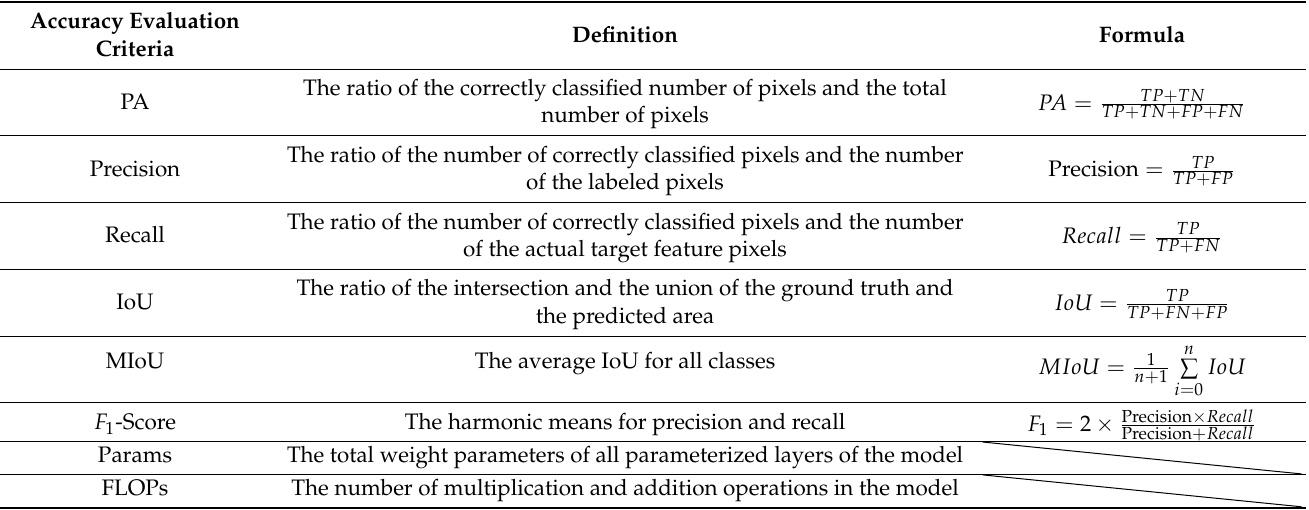
Table 2. Evaluation metrics for the accuracy